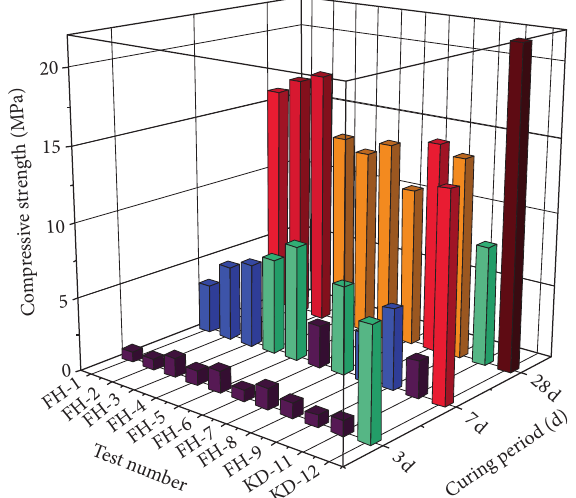
Figure 2: Variation of compressive strength of cementitious materials with different ratios.